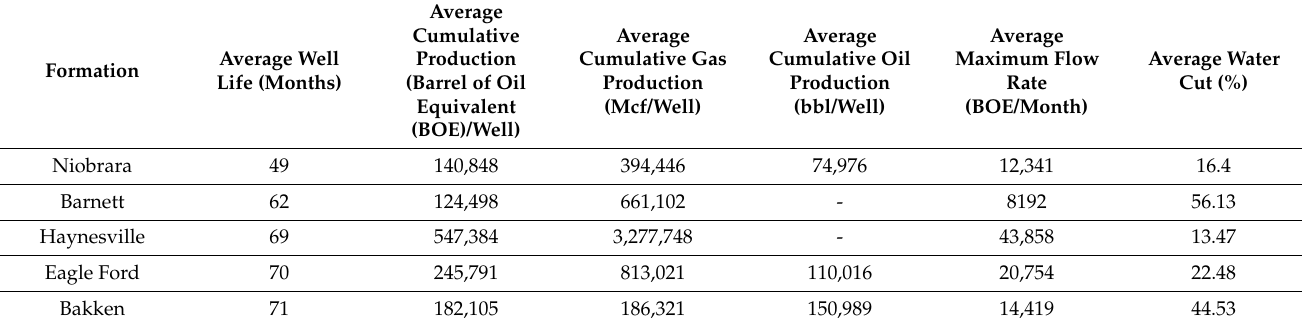
Table 2. Average major key production performance indicators for each